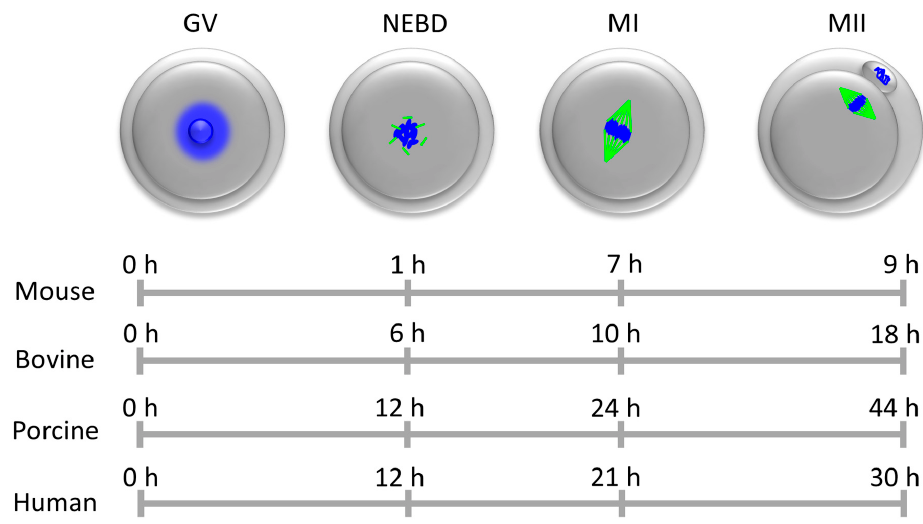
Figure 1. Time-sequence of meiotic maturation. The oocytes of most animal species are arrested in meiotic prophase I in so-called germinal vesicle (GV) stage, i.e., with an intact nuclear membrane. When oocytes begin meiotic maturation, the nuclear envelope breaks down (NEBD), the chromatin condenses and the first meiotic spindle forms (metaphase I, MI). Subsequently, oocytes pass through meiosis I, when the first polar body is extruded, and they are arrested in metaphase of meiosis II (MII) awaiting fertilization. Chromatin/chromosomes are depicted in blue, tubulin/spindle in